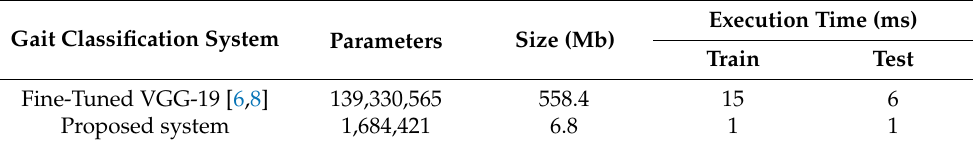
Table 2. Number of parameters, storage space, training and execution time (milliseconds) required by the VGG-19 [6,8] and the proposed systems.